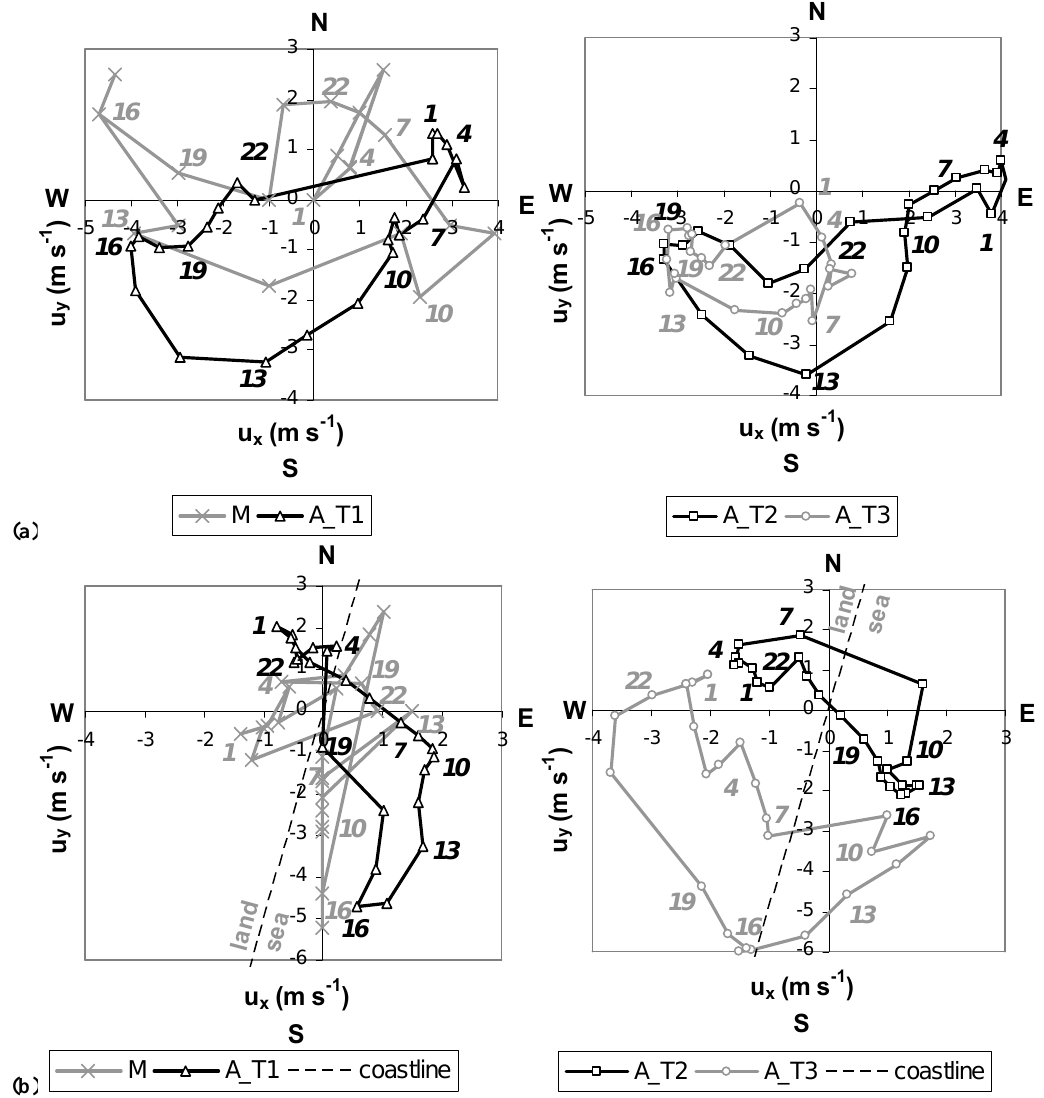
Fig. 10. Surface wind hodographs for Pula-airport (a) , Opatija (b) , Rijeka (c) and Malinska (d) and the corresponding modeled hodographs on 19 June 2000: measurements (M) and the A T1 case are on the left, the test without islands (A T2) and the test with idealized topography that is lower than 10m (A T3) are on the right. The wind vectors are directed toward the origin of the coordinate system. The numbers represent local standard time and the dashed line the orientation of the local coastline. The exception is Pula-airport, which is situated at the tip of Istria peninsula with the nearest coastline being 10km Figure 10. Surface wind hodographs for Pula-airport (a), Opatija (b), Rijeka (c) and Malinska Figure 10. Surface wind hodographs for Pula-airport (a), Opatija (b), Rijeka (c) and Malinska (d) and the corresponding modeled hodographs on 19 June 2000: measurements (M) and the (d) and the corresponding modeled hodographs on 19 June 2000: measurements (M) and the Figure 10. Surface wind hodographs for Pula-airport (a), Opatija (b), Rijeka (c) and Malinska Figure 10. Surface wind hodographs for Pula-airport (a), Opatija (b), Rijeka (c) and Malinska A_T1 case are on the left, the test without islands (A_T2) and the test with idealized A_T1 case are on the left, the test without islands (A_T2) and the test with idealized (d) and the corresponding modeled hodographs on 19 June 2000: measurements (M) and the (d) and the corresponding modeled hodographs on 19 June 2000: measurements (M) and the topography that is lower than 10 m (A_T3) are on the right. The wind vectors are directed topography that is lower than 10 m (A_T3) are on the right. The wind vectors are directed A_T1 case are on the left, the test without islands (A_T2) and the test with idealized A_T1 case are on the left, the test without islands (A_T2) and the test with idealized toward the origin of the coordinate system. The numbers represent local standard time and the toward the origin of the coordinate system. The numbers represent local standard time and the topography that is lower than 10 m (A_T3) are on the right. The wind vectors are directed topography that is lower than 10 m (A_T3) are on the right. The wind vectors are directed dashed line the orientation of the local coastline. The exception is Pula-airport that is situated at dashed line the orientation of the local coastline. The exception is Pula-airport that is situated at toward the origin of the coordinate system. The numbers represent local standard time and the toward the origin of the coordinate system. The numbers represent local standard time and the the tip of Istria peninsula with the nearest coastline being 10 km away. the tip of Istria peninsula with the nearest coastline being 10 km away. dashed line the orientation of the local coastline. The exception is Pula-airport that is situated at dashed line the orientation of the local coastline. The exception is Pula-airport that is situated at the tip of Istria peninsula with the nearest coastline being 10 km away. the tip of Istria peninsula with the nearest coastline being 10 km away.